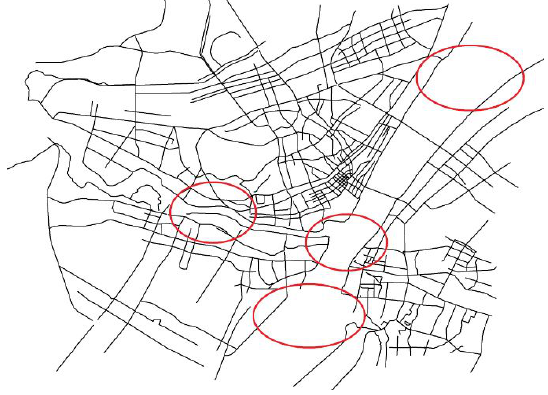
Figure 3. The roads selected by importance